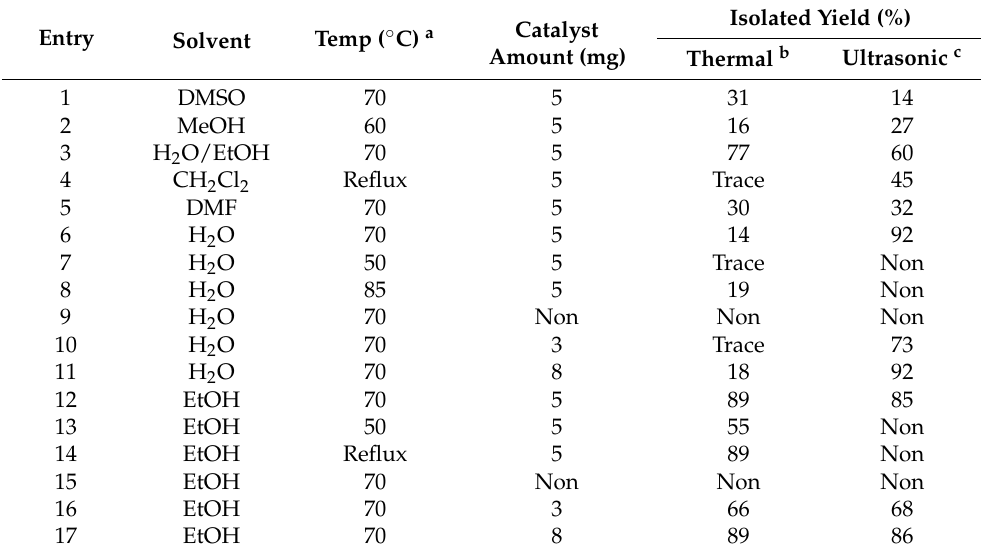
Table 1. The optimization of the reaction conditions for the synthesis of 4g (R = 4-NO 2 ).